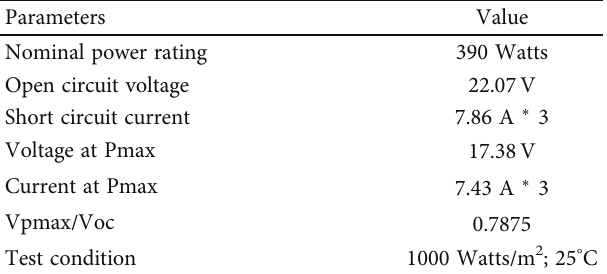
Table 1: The speci fi cations of the solar PV